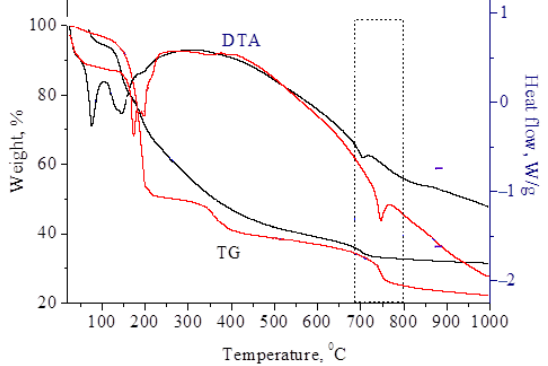
Figure 3. TG and DTA curves of molybdenum blue xerogels synthesized using glucose (black lines) and hydroquinone (red lines).